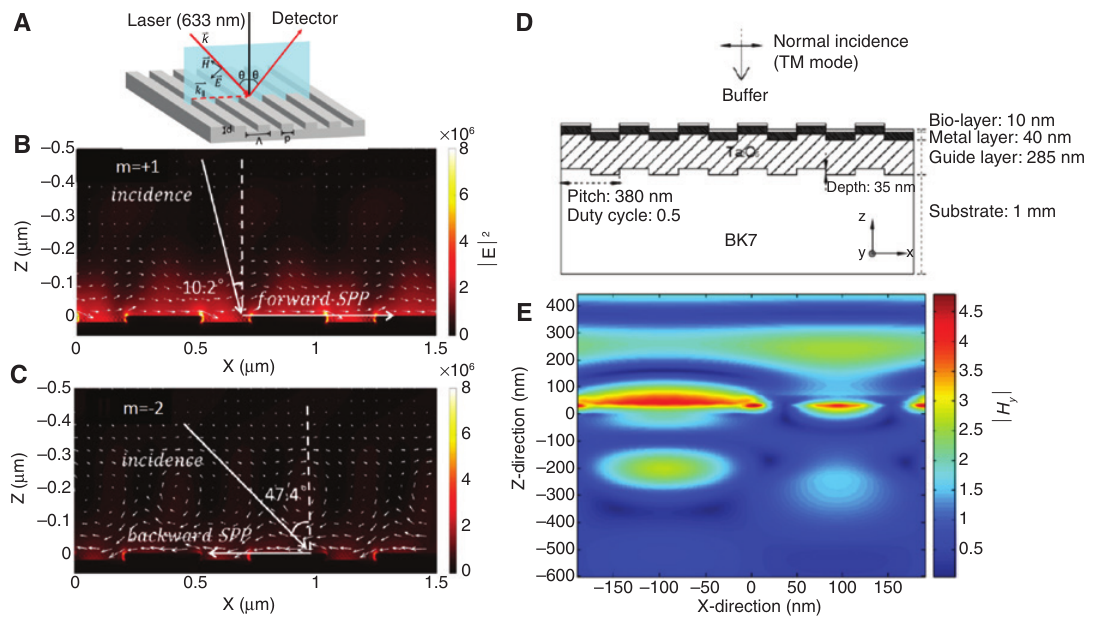
Figure 8: IIlustration of the field enhancement in grating configurations upon exciting SPR and GMR. (A) Scheme of surface relief silver grating at oblique incidence excitation and the electric field intensity distribution at the ESP resonance for (B) when the first-order diffraction beam m = −1 excites the ESP and (C) when the second-order diffraction beam m = −2 excites the ESP. (D) Geometry of the metallic grating coupled with GMR structure, and the magnetic field amplitude distribution along the y direction at the ESP resonance (E). Parts A–C are reproduced with permission from [57], while parts D–E are from